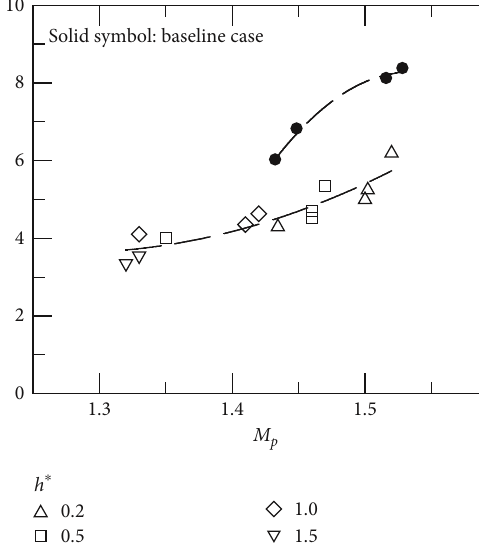
Figure 12: Normalized separation length versus peak Mach number.